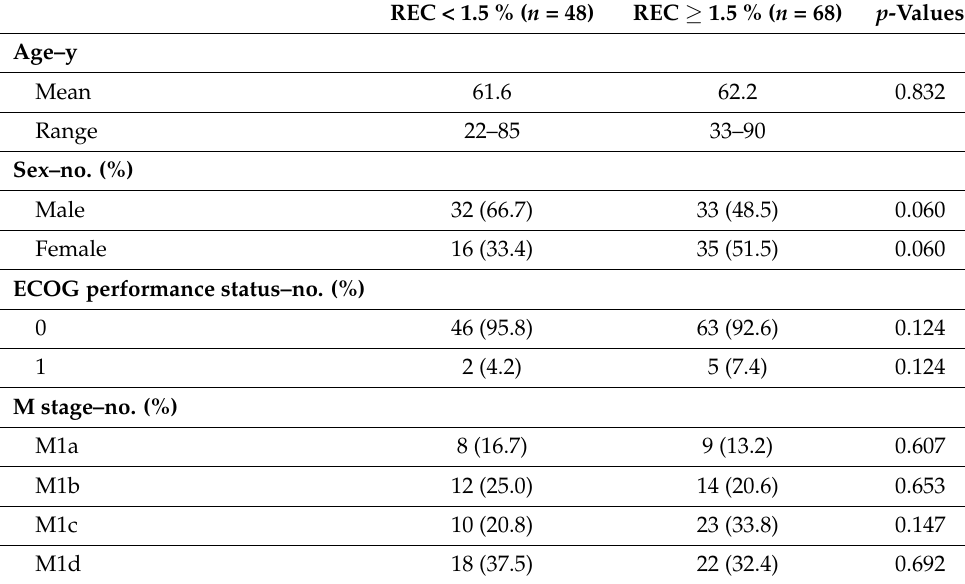
Table A2. Baseline characteristics of the patients stratified by relative eosinophilic count (REC). Percentages are given in